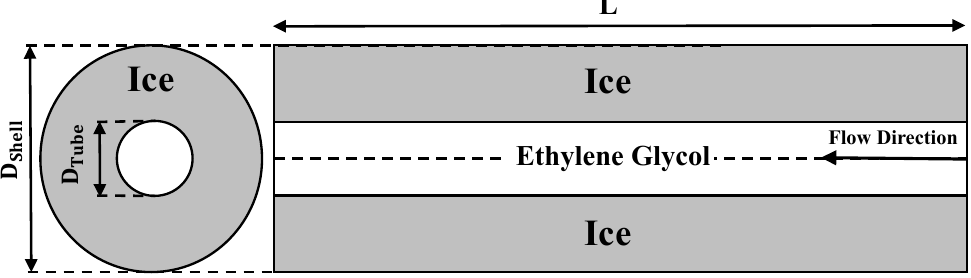
Figure 4. Schematic of validation model of the melting process of the ice storage system.